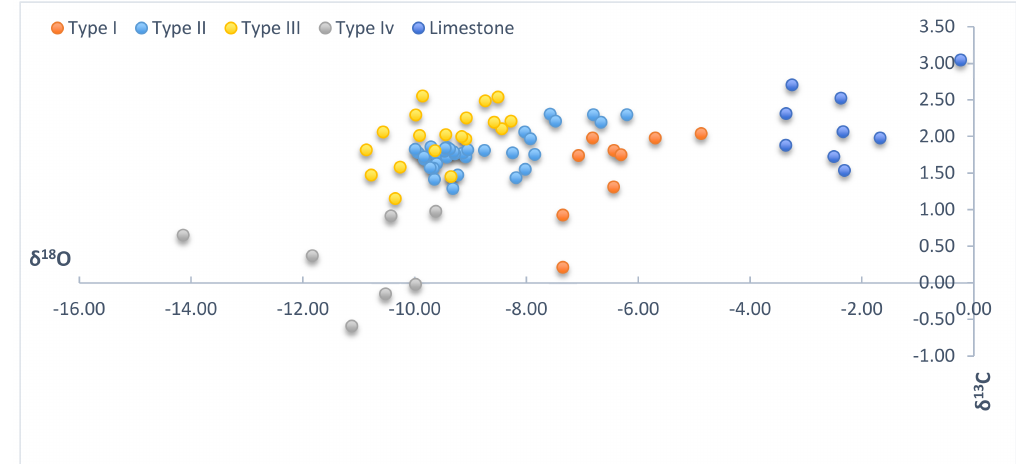
Figure 13. Cross-plot of oxygen and carbon isotopic compositions (VPDB) of selected dolomite, calcite phases (Type I to IV: see text) and pristine limestone from Triassic–Jurassic succession ( n = 80).